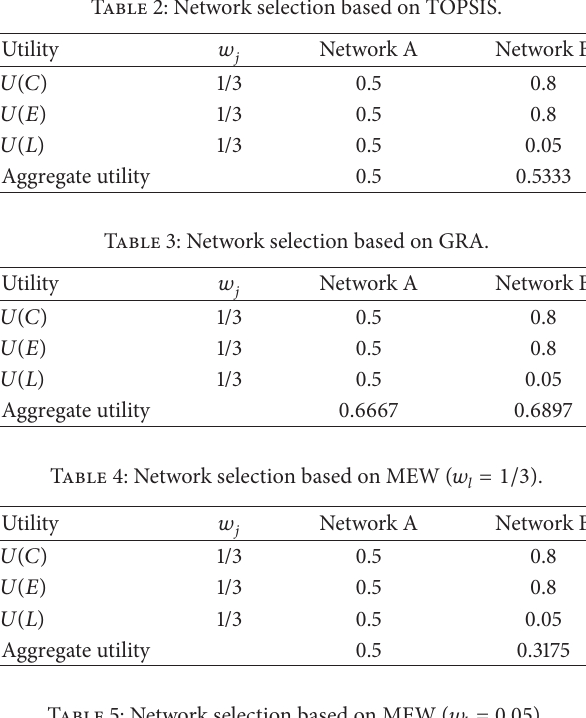
Table 5: Network selection based on MEW ( 𝑤 𝑙 = 0.05 ).